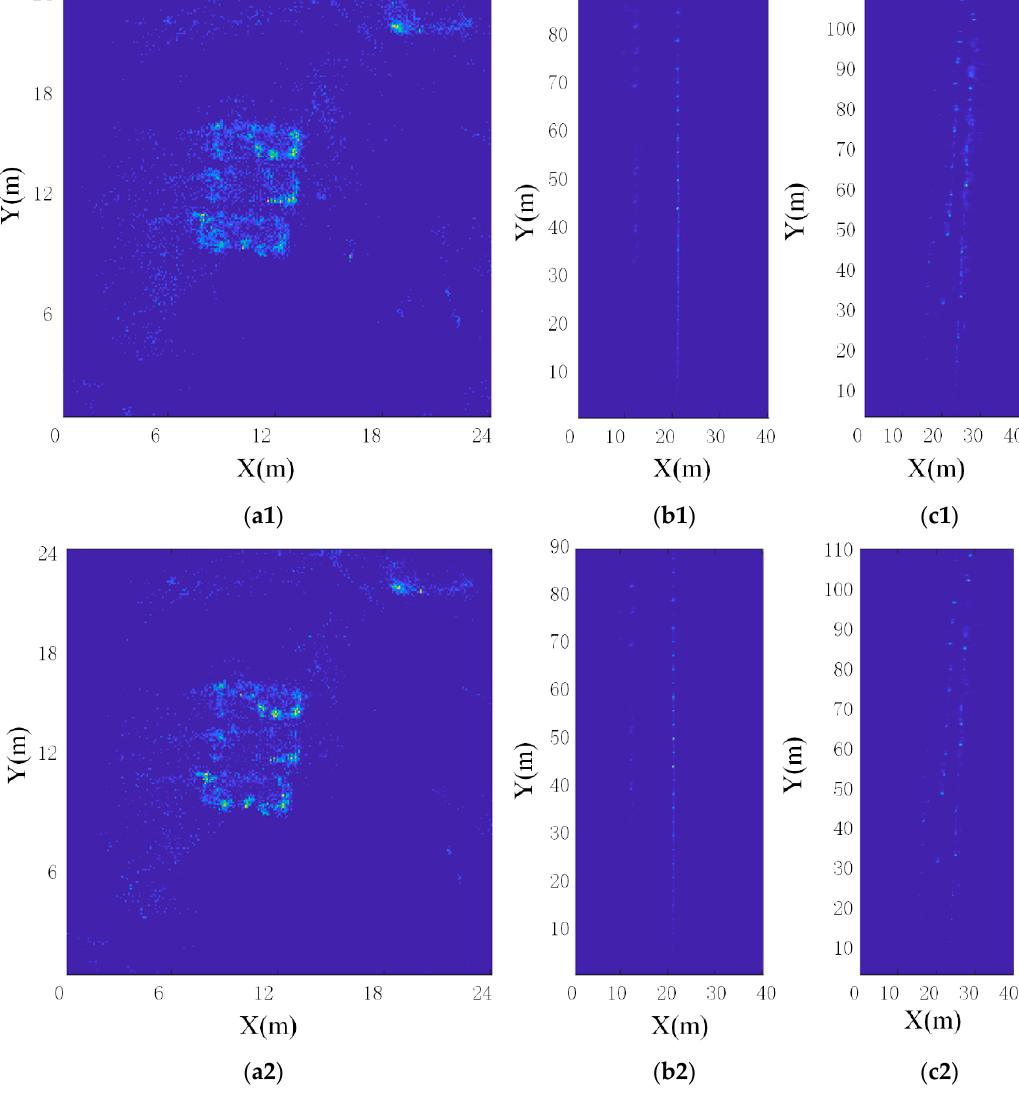
Figure 15. The three sets of pictures ( a – c ) correspond to the maps of the three scenes. Among them, ( a1 – c1 ) are OGM and ( a2 – c2 ) are R-OGM. ( a1 – c1 ) are OGM and ( a2 – c2 ) are